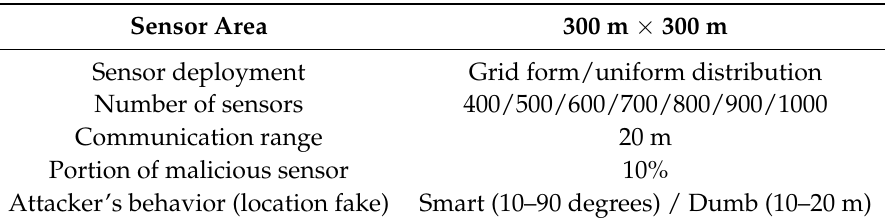
Table 5. Simulation setup and parameters for the proposed